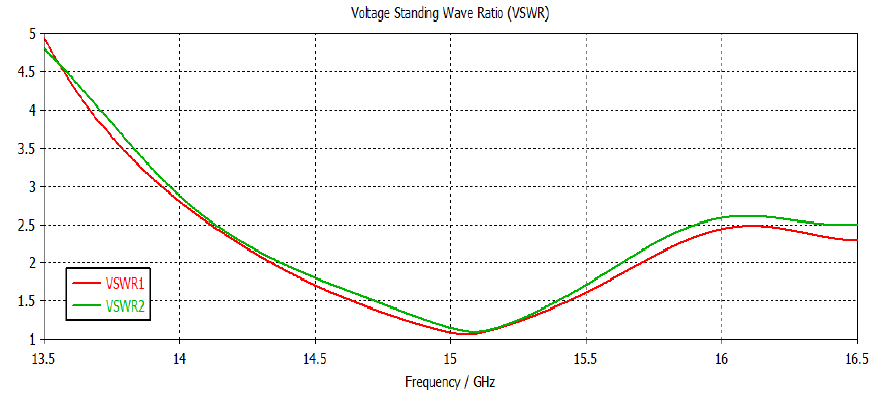
Fig. 5. Four-element antenna array layout – isometric and top view.